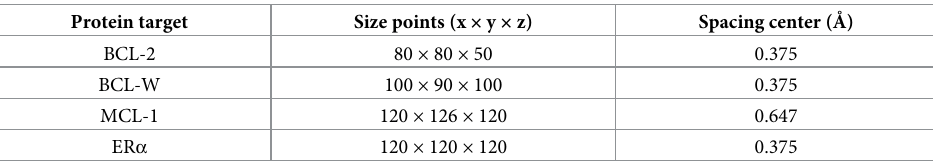
Table 1. The grid box values used for molecular docking